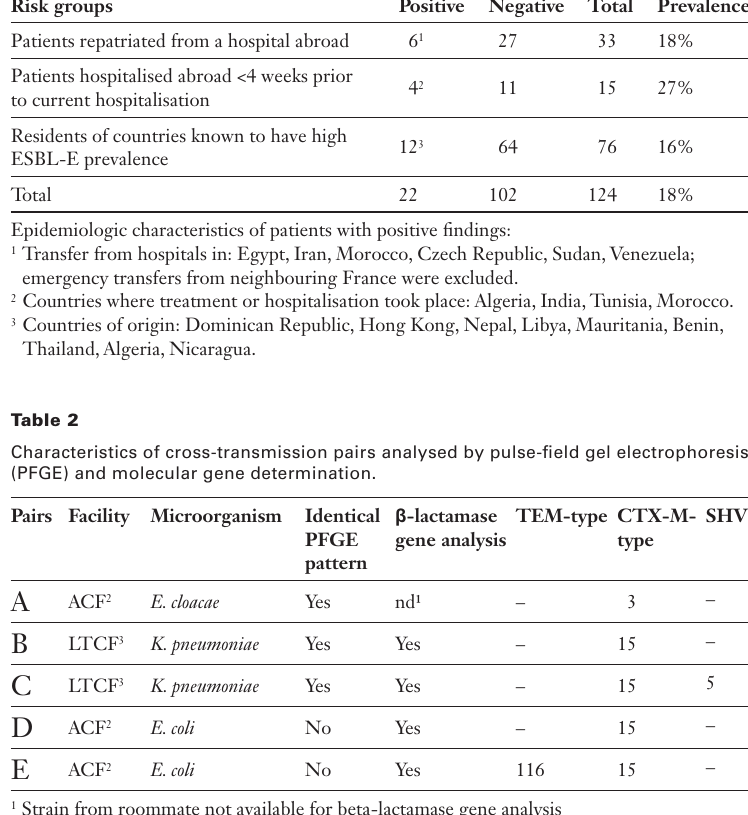
Category II: screening upon admission in predefined risk groups. Risk groups